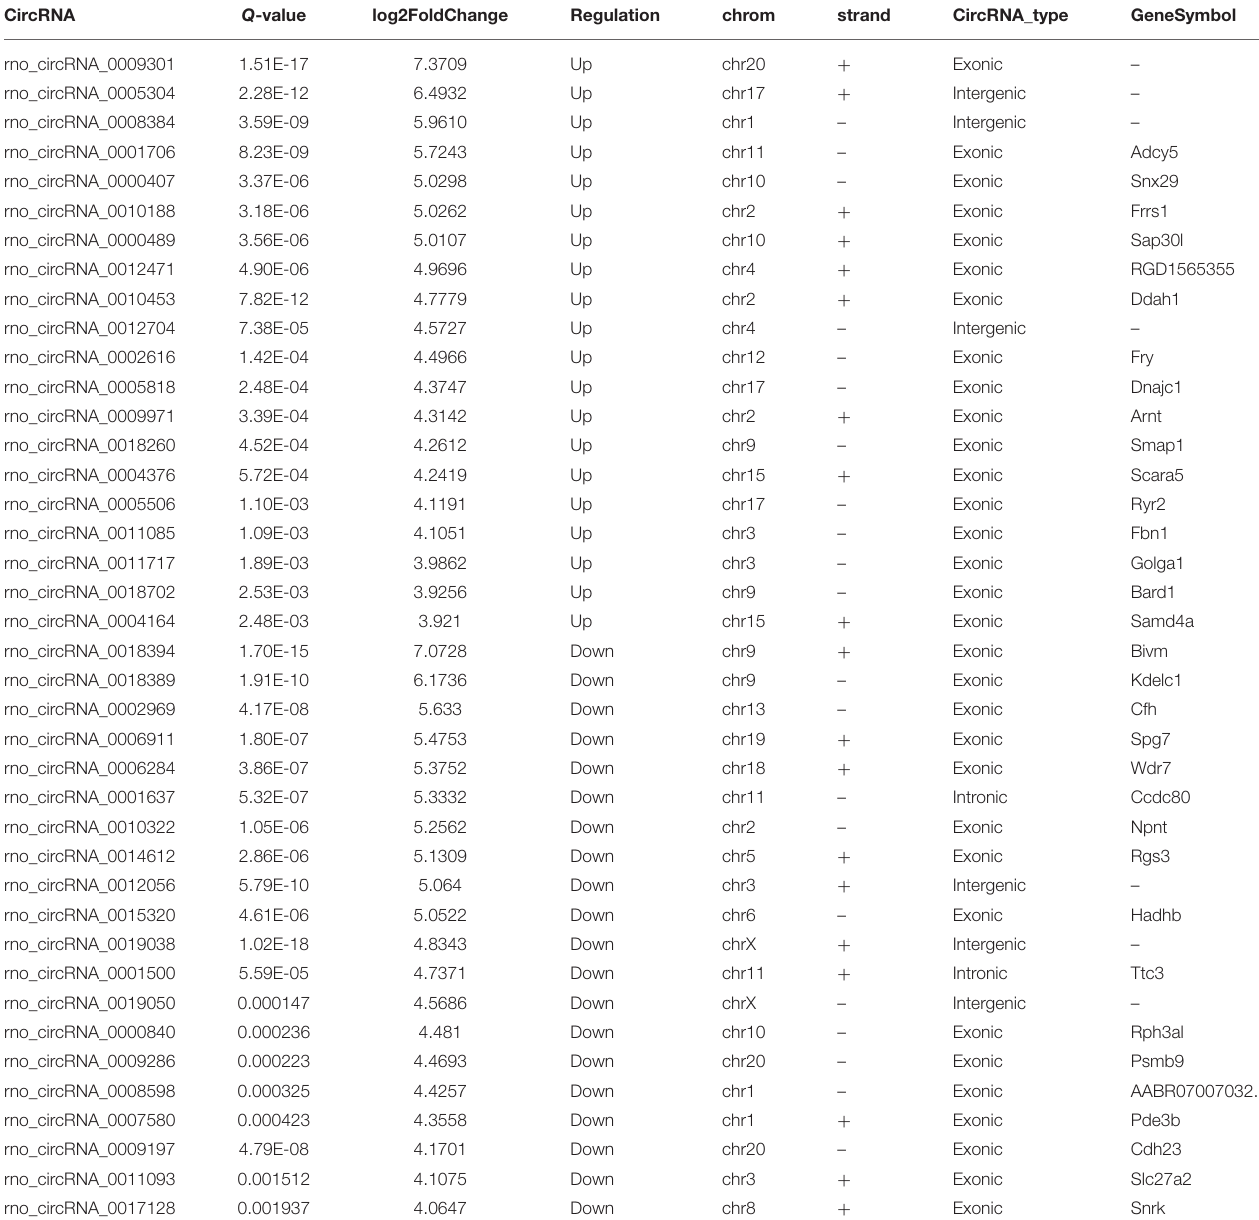
TABLE 1 | Top 20 significantly up-regulated and down-regulated circRNAs in SHR rat (|log2FoldChange| > 4, Q -value < 0.05). CircRNA Q -value log2FoldChange Regulation chrom strand